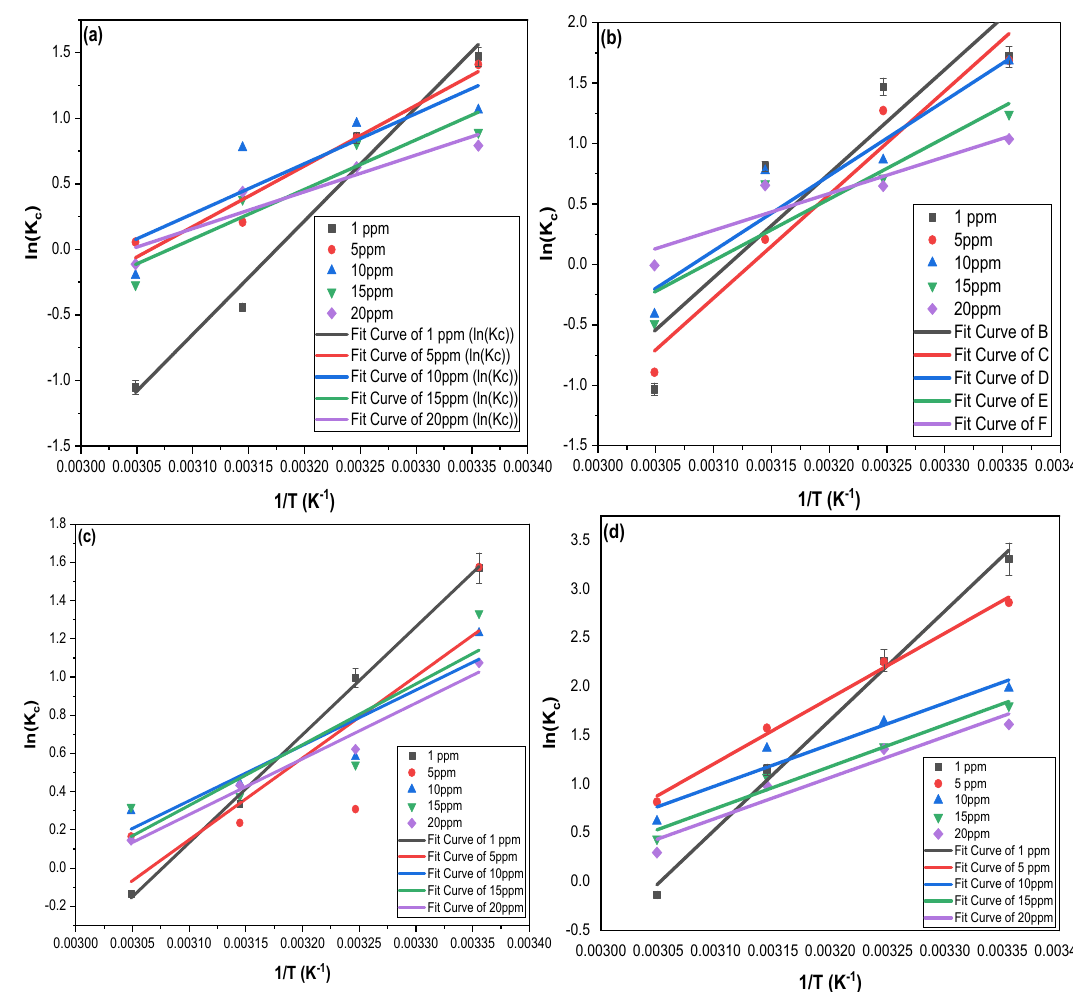
Figure 6. The plot of ln K c against 1/ T for the adsorption of different initial feed concentrations of ( a ) MF on WTC, ( b ) MF on ATC, ( c ) MF on WTC, and ( d ) MF on